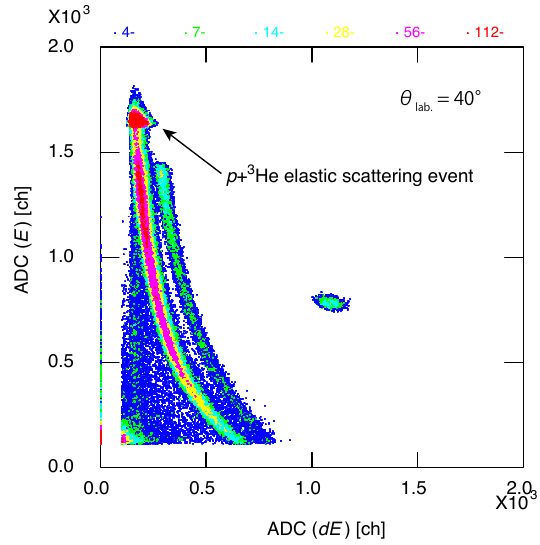
Figure 2: Two-dimensional plot of the light outputs of the dE and E